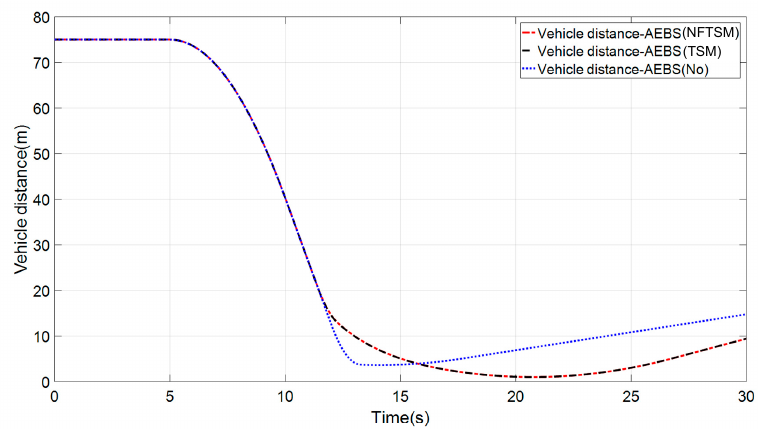
Figure 8. Comparison of relative distance.